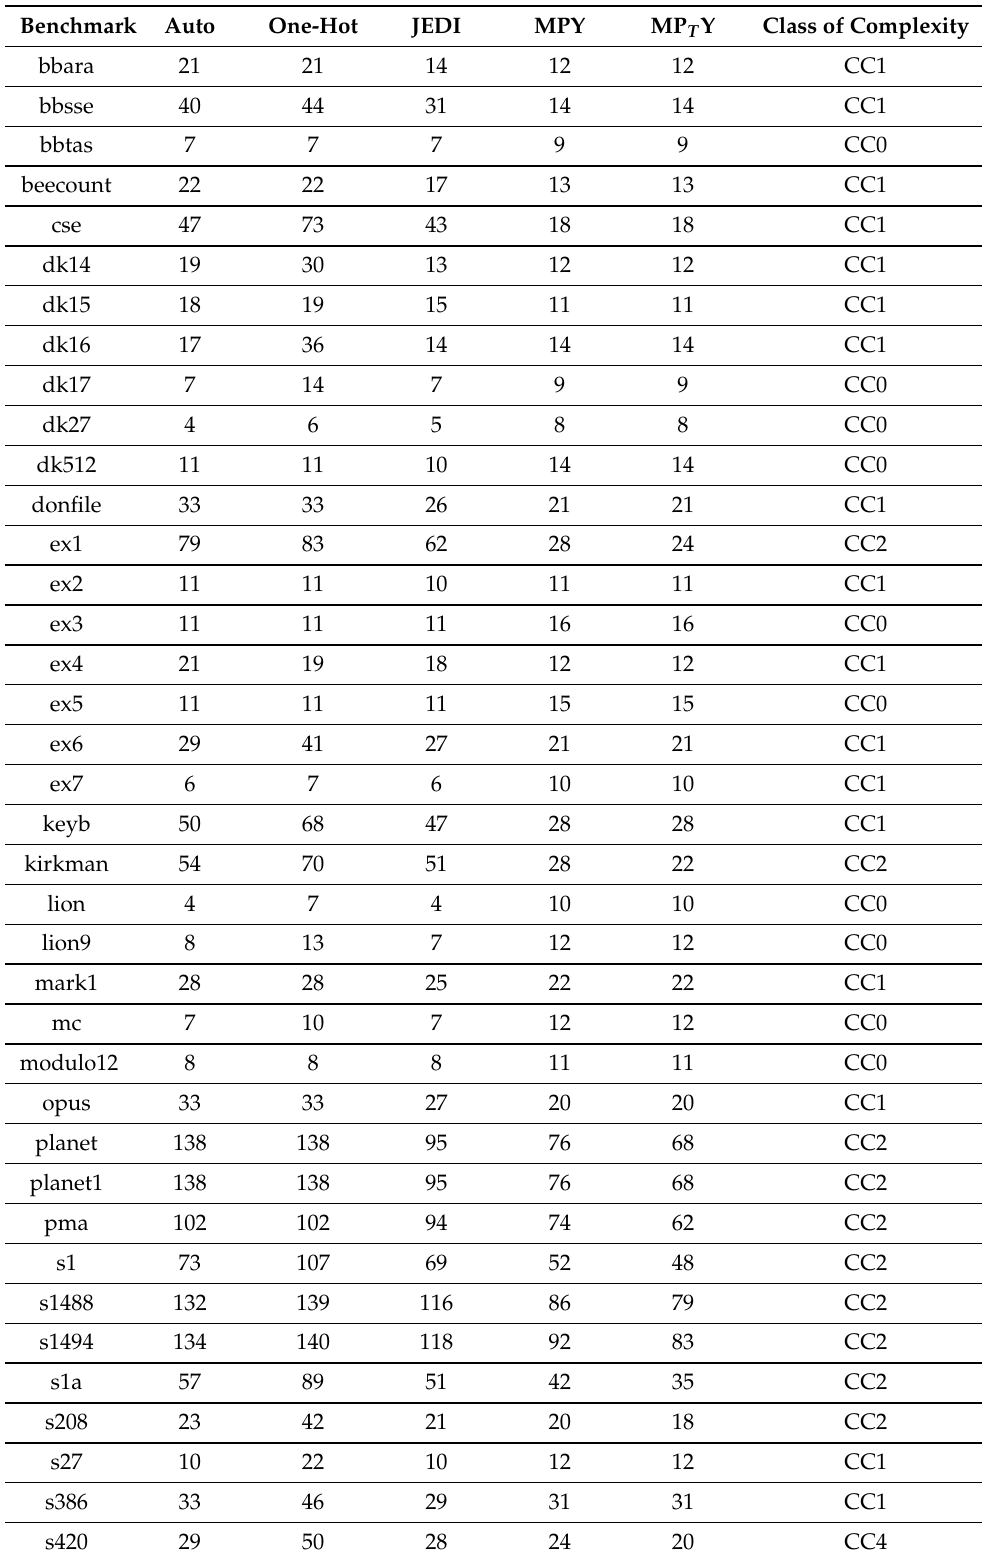
Table 7. Experimental results (the LUT